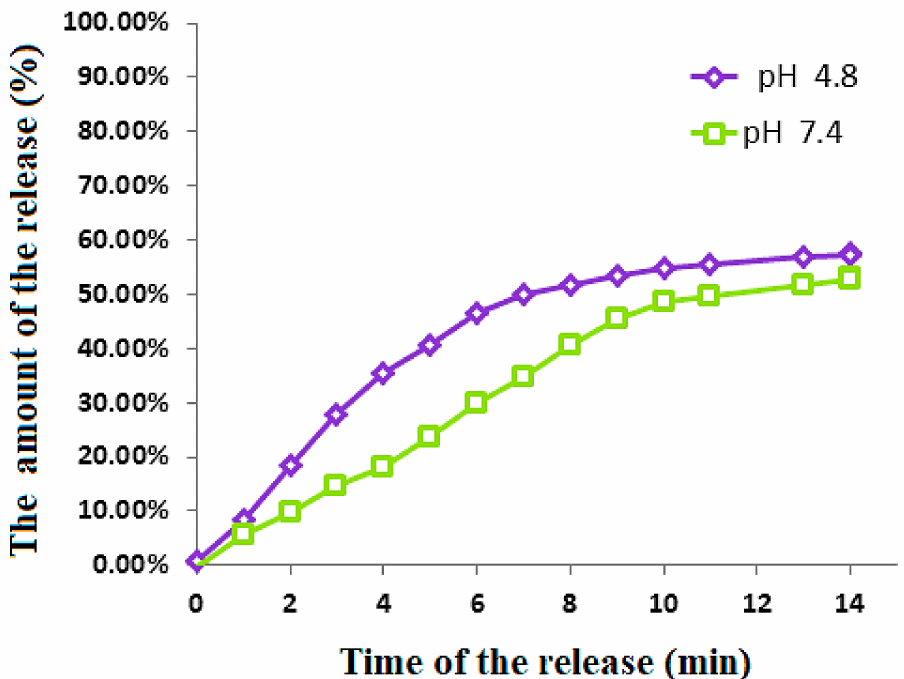
Figure 9. Release of 5- fluorouracil from its physical mixtures and the FPVAFU-ZLDH sample into the phosphate-buffered solutions at pH 4.8 and pH